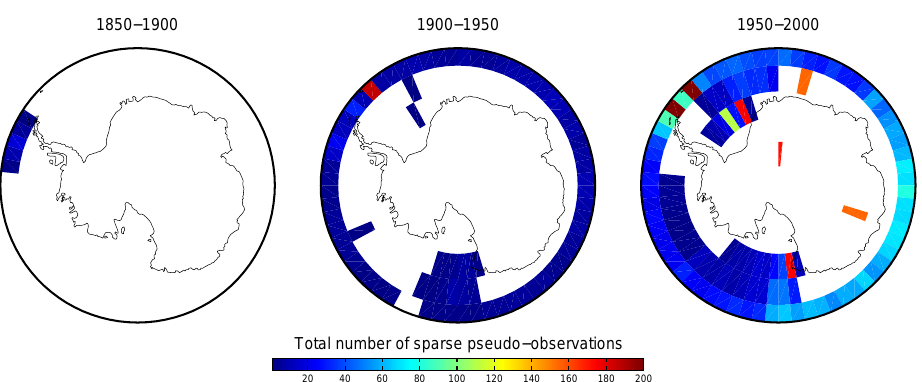
Fig. 5. Number of seasons of the sparse pseudo-observations per grid cell southward of 60 ◦ S over different time periods: 1850–1900 (left), 1900–1950 (middle), and 1950–2000 (right). while for the model without any data assimilation correlation is 0 . 78 . In the area southward of 66 ◦ S where only a few pseudo-observations are located, we have a good estimation of the trend but not of the variance. Moreover, the trend reconstruction is achieved mainly due to the well-defined 365 forcing, not due to data assimilation. Indeed, when no data assimilation is used correlation is 0 . 56 and correlations obtained by the data-assimilation methods are 0 . 58 , 0 . 59 , and 0 . 62 for the nudging, the sequential importance resampling filter, and the nudging proposal particle filter, respectively.